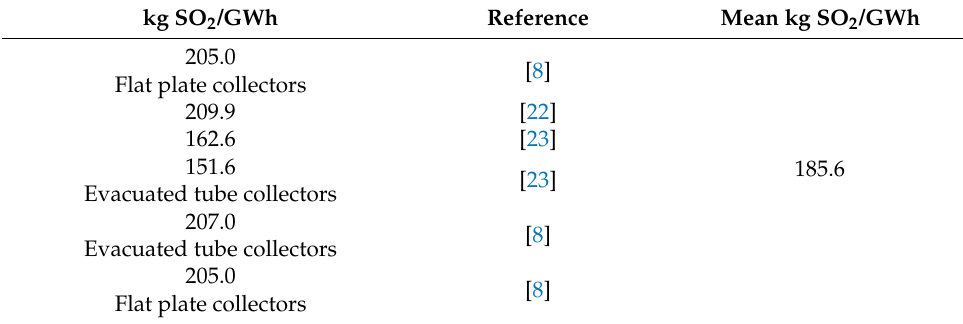
Table 6. SO 2 emissions (DHW production).